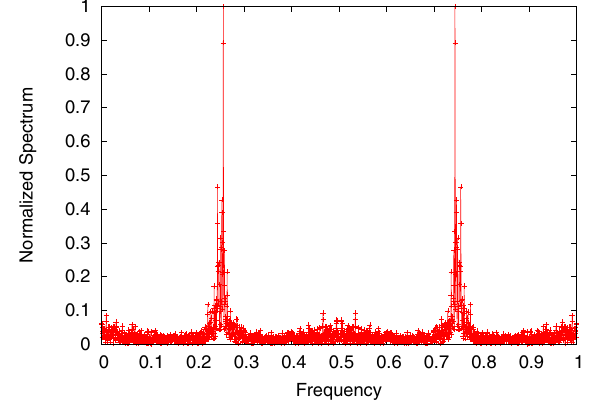
FIG. 6. Spectrum analysis of the electric field in y -direction at 0 . 267 while the horizontal x ¼ y ¼ 0 . The vertical tune is Q y ¼ ≃ 1 . 001 is close to an integer value. A peak occurs at the tune Q x tune position, while other frequencies are no longer excited.